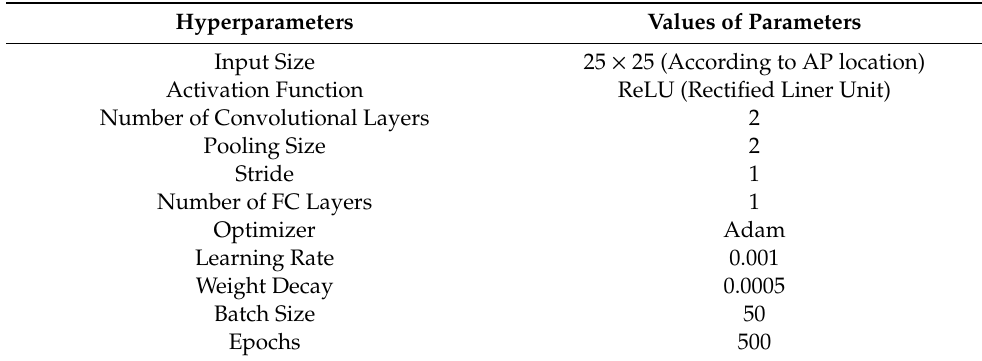
Table 1. Hyperparameters of the CNN